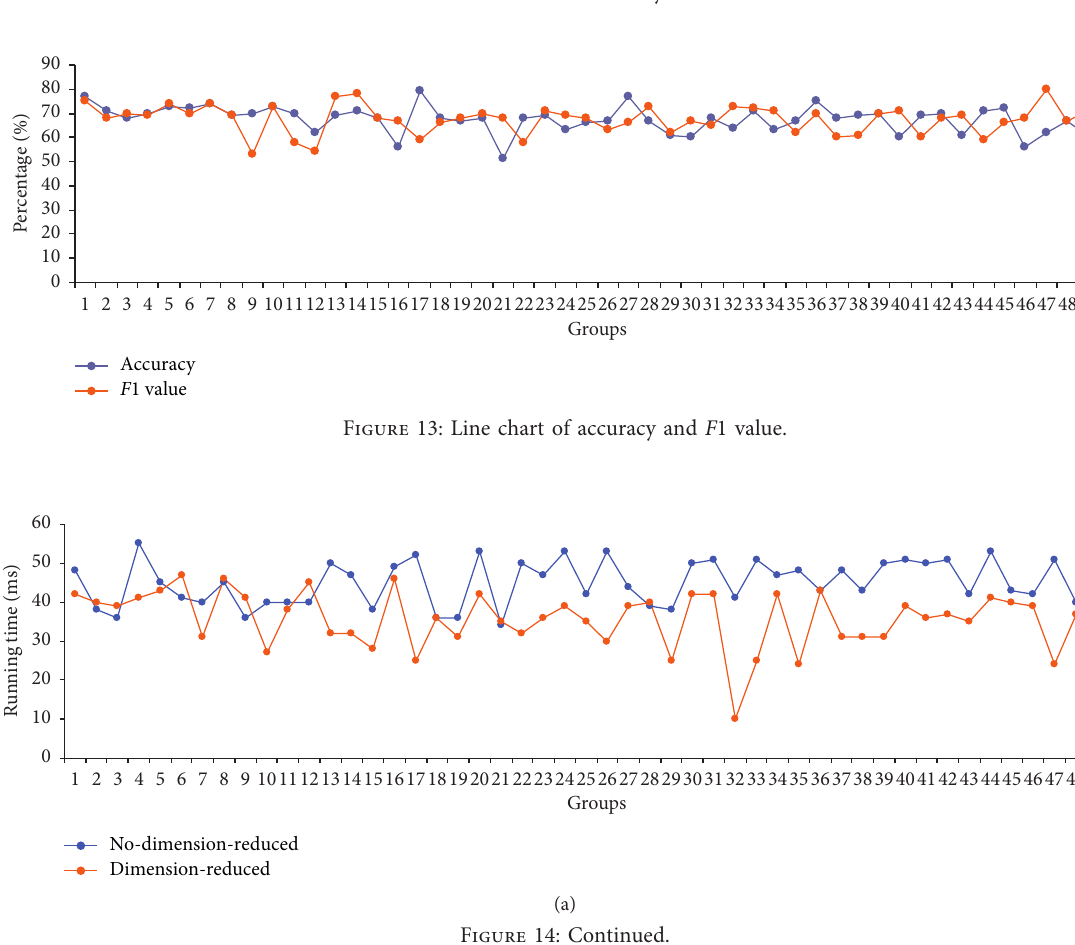
Figure 12: Confusion matrix of entity semantic fusion.